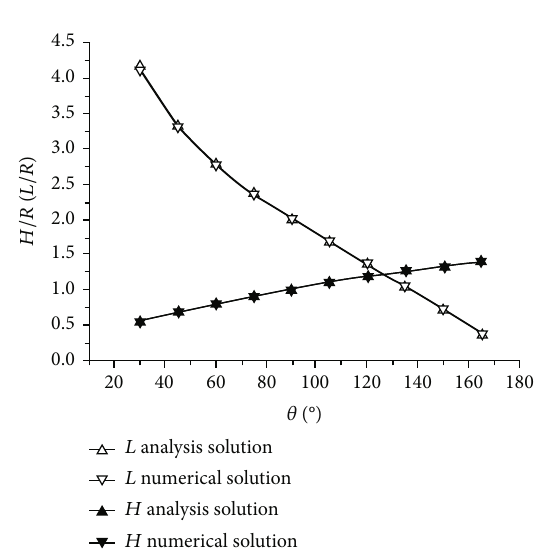
Figure 7: Changes of droplet height and width with contact angles.